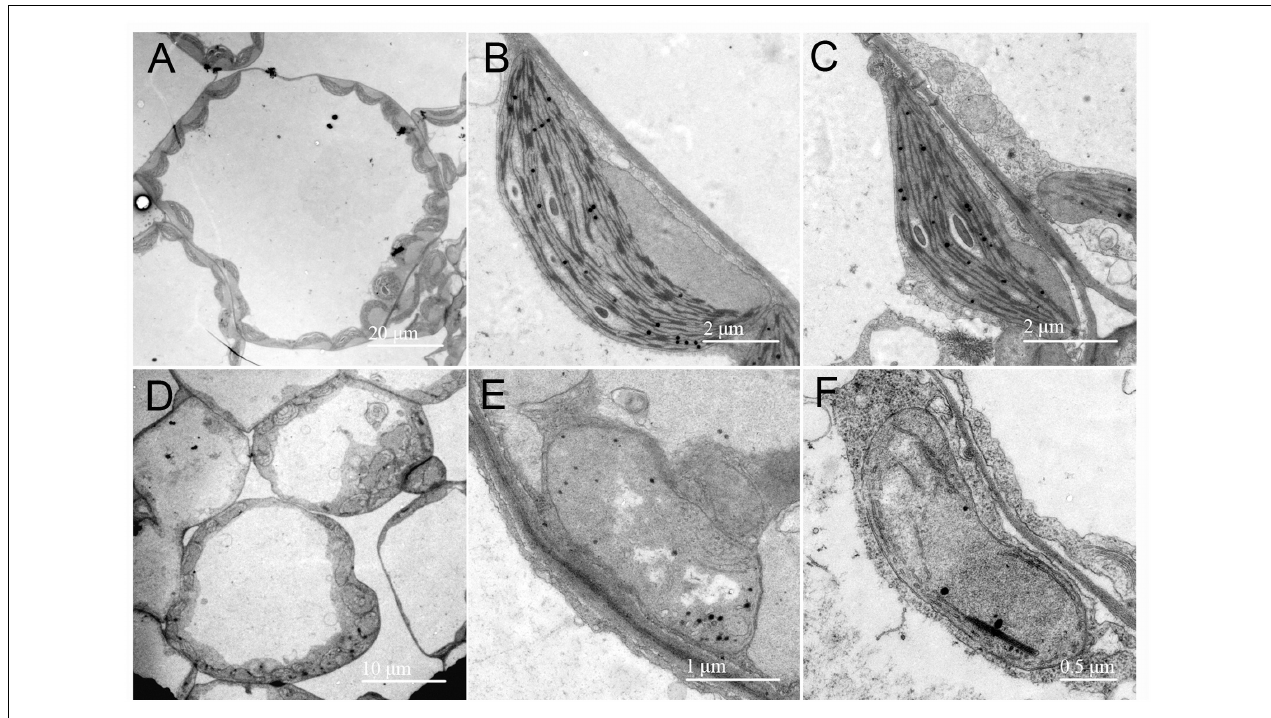
FIGURE 4 | Chloroplast ultrastructure observation in the wild type and the rp8 mutant. Transmission electron micrographs of chloroplasts in leaves from the 12-day-old wild type (A–C) and the rp8 mutant (D–F) grown under low light intensity at 30 µ mol photons m - 2 s - 1 . (A,D) Are the overview of mesophyll cell chloroplasts. (B,E) Are chloroplasts of cotyledons, (C,F) Are chloroplasts of true leaves. Scale bars are